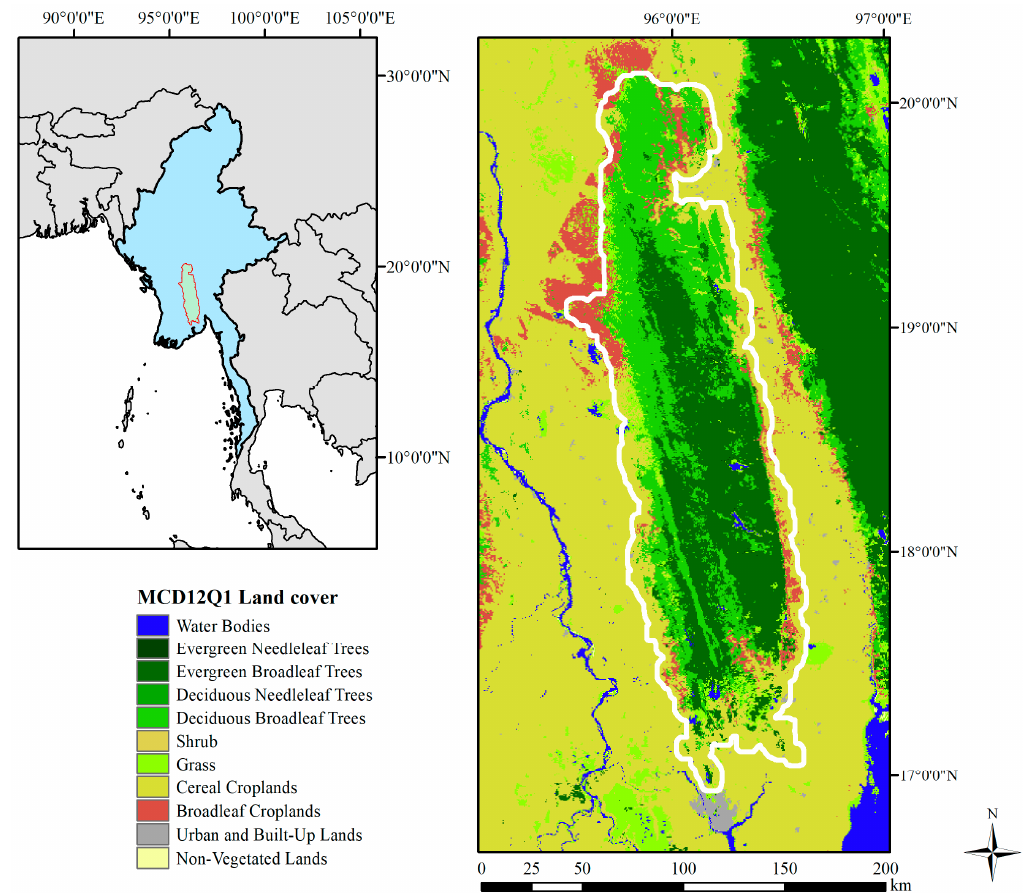
Figure 1. Location of the study area. MCD12Q1 Version 6 Land cover type product [54] for 2016 was used for visualization. The World Borders Dataset provided by Thematic Mapping (http://thematicmapping.org/) was used as the country border.